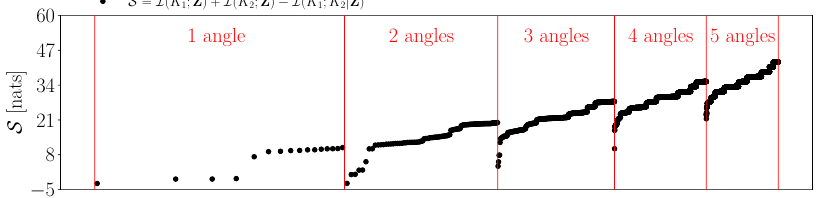
− Figure 6. The variation of information criterion 6884 combinations. The vertical red lines show the groupings with respect to the number of angles in a protocol and values are sorted in increasing order within each such grouping. The x-axis is S represents the index associated with the protocol and is in logarithmic scale to capture the spread between one angle in a protocol (16 values) vs five angles in a protocol (4368